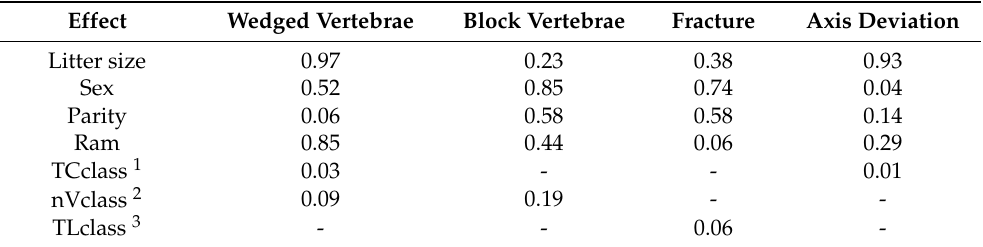
Table 6. p -values of the global F-test for the model effects on the probability of occurrence of the four features wedged vertebrae, block vertebrae, fracture, and axis deviation.